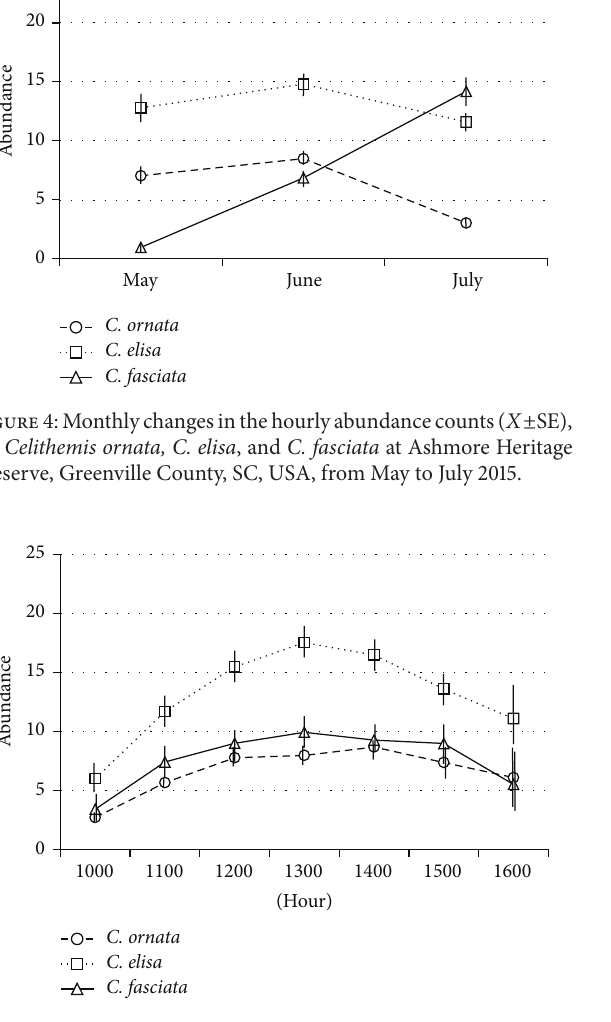
Figure 5: Diel changes in hourly abundance counts ( 𝑋 ± SE), averaged over the entire sampling period, for Celithemis ornata , C. elisa , and C. fasciata at Ashmore Heritage Preserve, Greenville County, SC, USA, from May to July 2015.